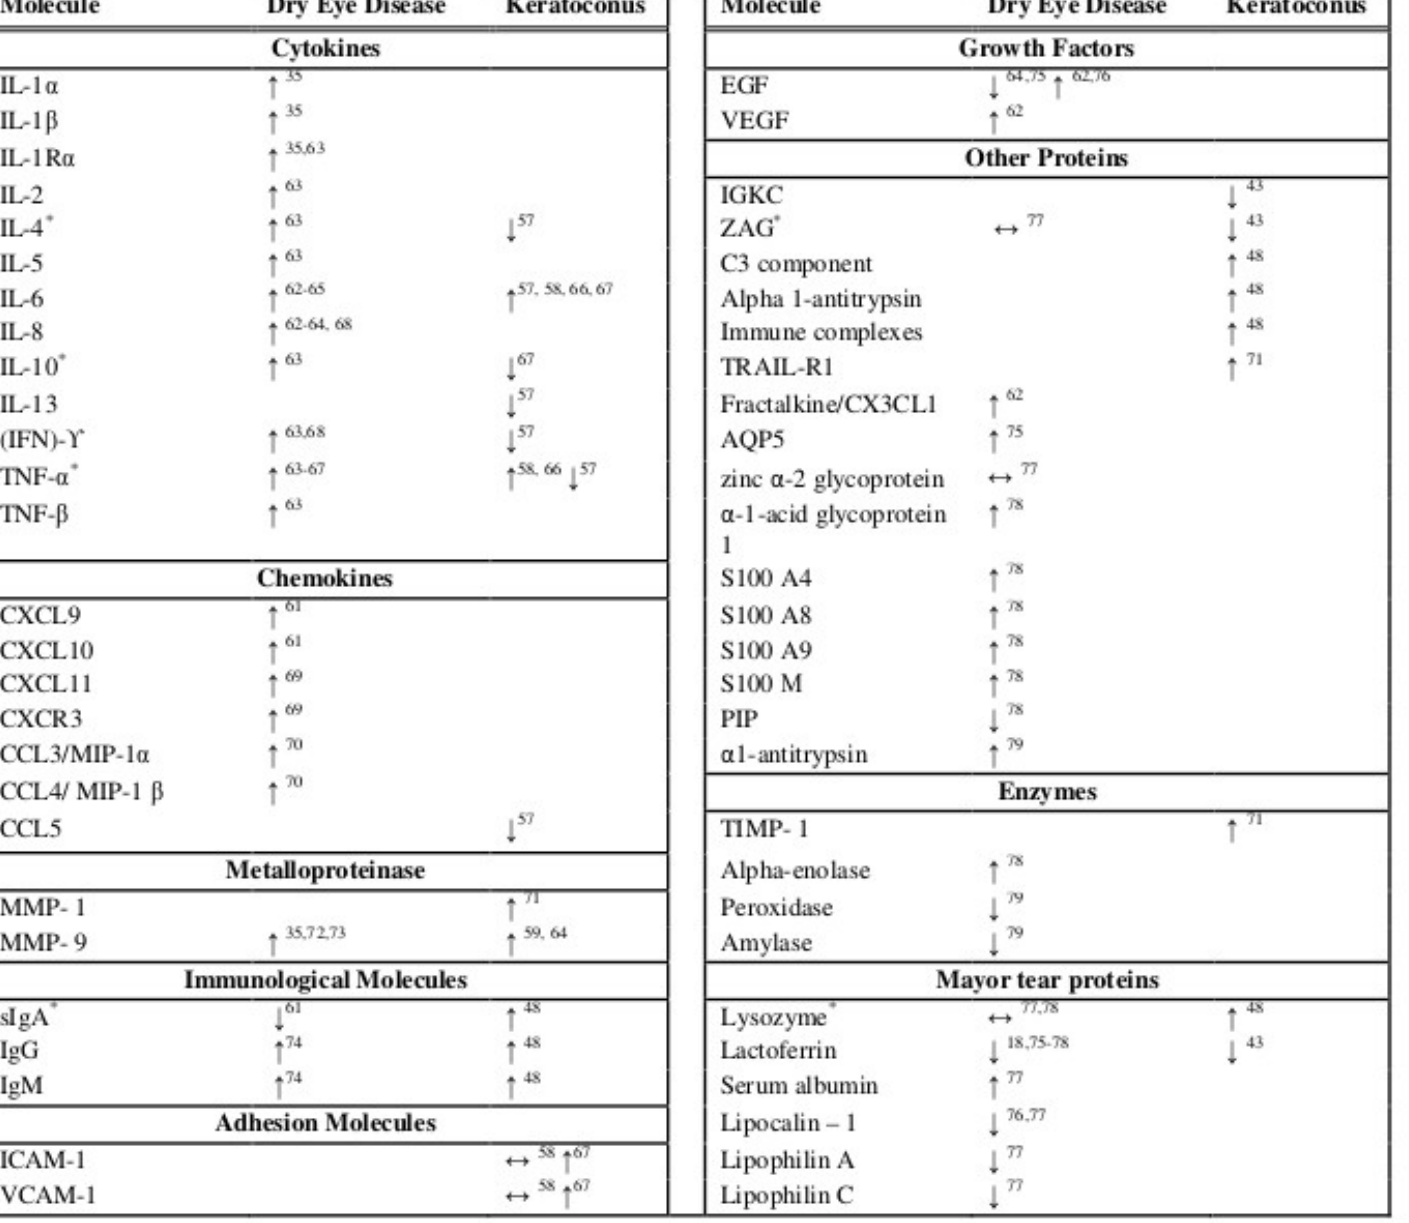
Table 1 Overview of the relative levels of immunoproteins in the tears of patients with dry eye disease and keratokonus. ↔ No change in protein level compared to coltrol; ↑ Increase in protein level compared to control; ↓ Decrease in level compared to con - trol; *Proteins of which the levels differ in KC and DED; AQP5, Aquaporin 5; CXCL, Chemokine (C-X-C motif) ligand; CXCR, Chemokine receptor; EGF, Epidermal growth factor; ICAM, Intercellular adhesion molecule; IFN, Interferon; IgG, Immunoglobulin G; IGKC, Immunoglobulin kappa chain; IgM, Immunoglobulin M; IL, Interleukin; MIP, Macrophage inflammatory protein; MMP, Metalloproteinase; PIP, Prolactin-inducible protein; S100, calgranulin; S100 A11, calgizzarin; sIgA, Secretory immunoglobulin A; TIMP, Tissue inhibitor of metalloprotease; TNF- α, Tumour necrosis factor alpha; TRAIL-R1, Tumor necrosis-related apoptosis- inducing ligand-R1; VCAM, Vascular adhesion molecule; VEGF, Vascular endothelial growth factor; ZAG, Zinc-